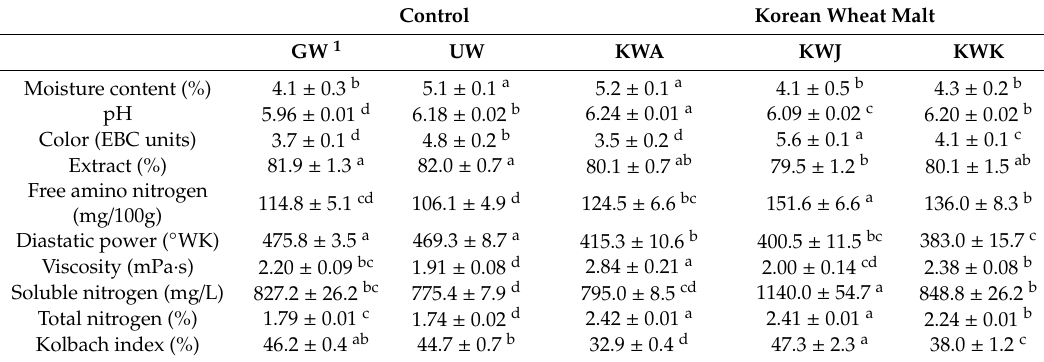
Table 2. Malt quality properties of wheat